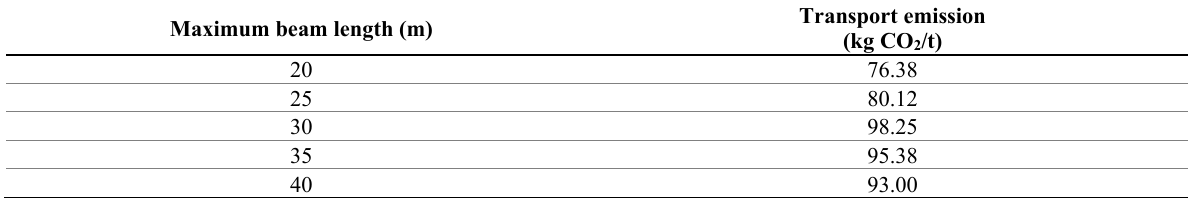
Table 9. CO 2 emissions from beam transportation stage (distance up to 50 km, one way)